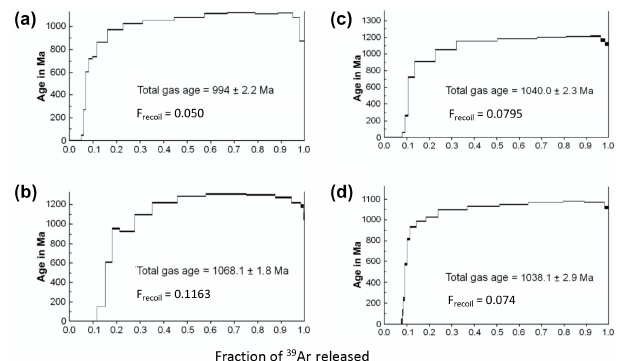
Figure 6. Ar–Ar dating results and argon release diagrams for il- lites from the fault gouges of < 2µm size fraction for sample Dob- 476.6 (a) , Dob-441 (b) , JC-408 (c) , and JC-360.7 (d) . Note consis- tent Ar–Ar total gas ages except for sample